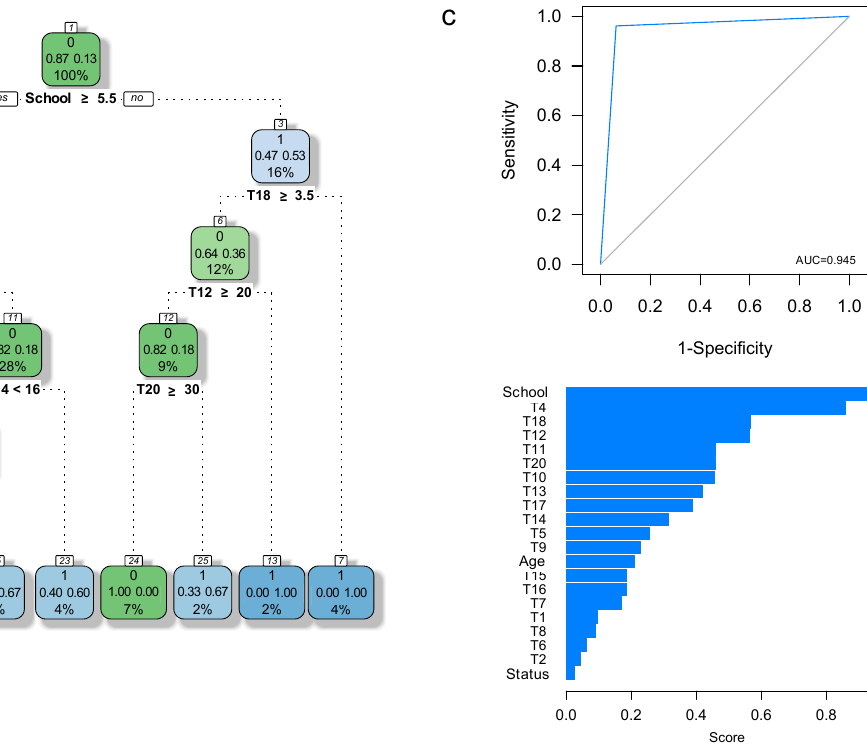
Figure 3. ( a ) Sensitivity ( S e ; black line) and specificity ( S p ; red line) as a function of the cut-off value for the MMSE in this Caribbean community. The optimal cut-off point is shown in green. ( b ) An ARPA-based predictive model for HAND screening when the MMSE optimal cut-off value is used to define HAND in all 120 assessed individuals. ( c ) ROC curve and variable importance for the derived model. Status: HIV-1 Infection status (0: control; 1: case). Other conventions as in Figure